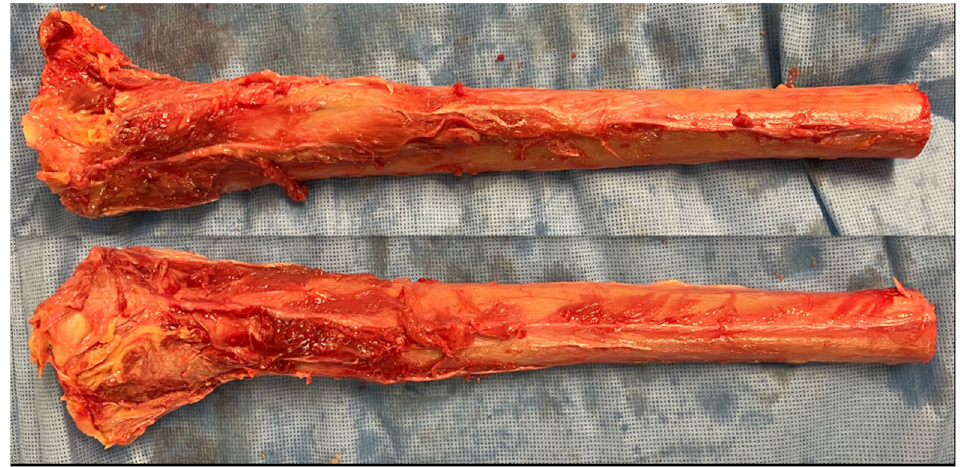
Figure 1. Two six-inch-long unembalmed tibial sections were harvested. Subsequently, they were placed into a 37 °C water bath, to simulate normal body temperature.